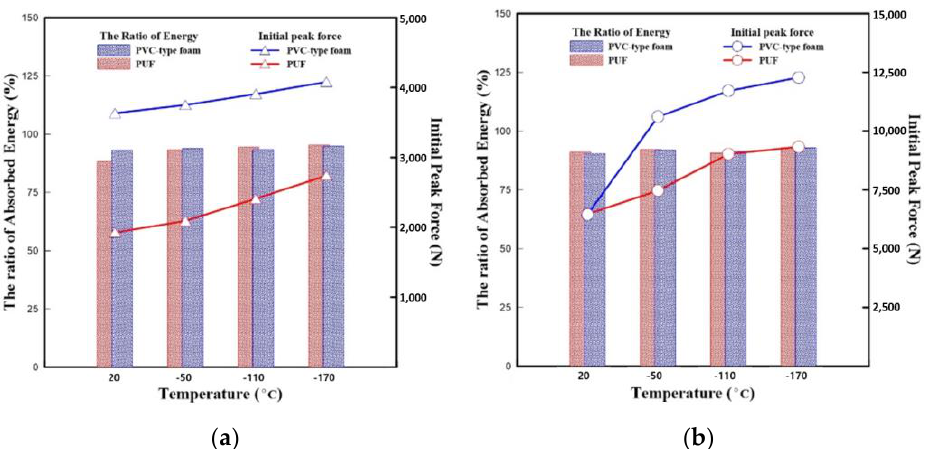
Figure 15. Comparison of specimens in terms of the initial peak force and the ratio of the absorbed energy by temperature: ( a ) for low densities (L), ( b ) for high densities (H).